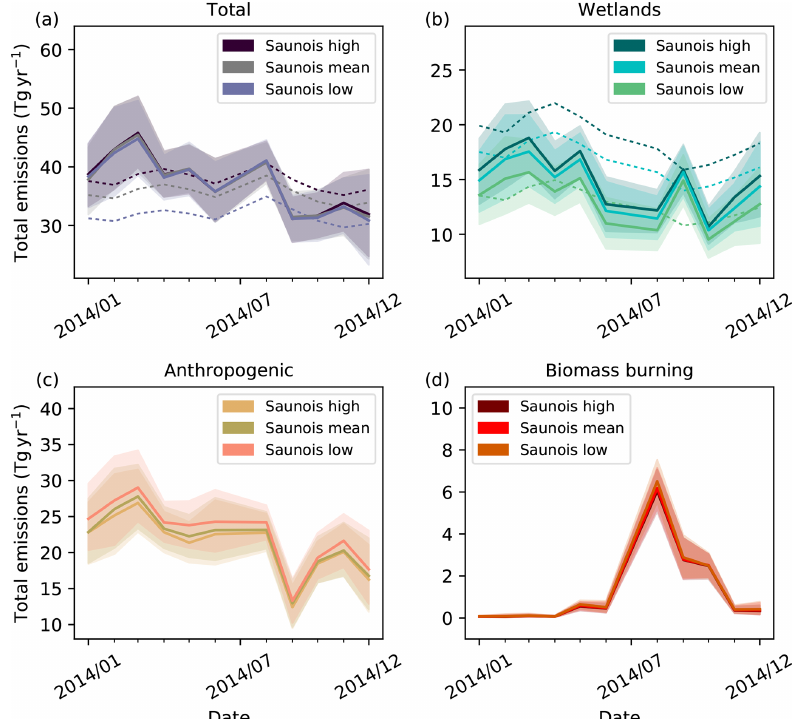
Figure A6. Brazil’s CH 4 emissions in a sensitivity inversion using a perturbed a priori wetlands emissions magnitude. All other components were held at the original configuration. A priori wetland emissions for all of South America were scaled to 32 (low), 44 (mean) or 50 (high) Tgyr − 1 (as defined for Tropical South America in Saunois et al., 2016). (a) Total, (b) wetland, (c) anthropogenic and (d) biomass burning emissions. Prior emissions are only shown in (a, b) as they only vary for these components in this